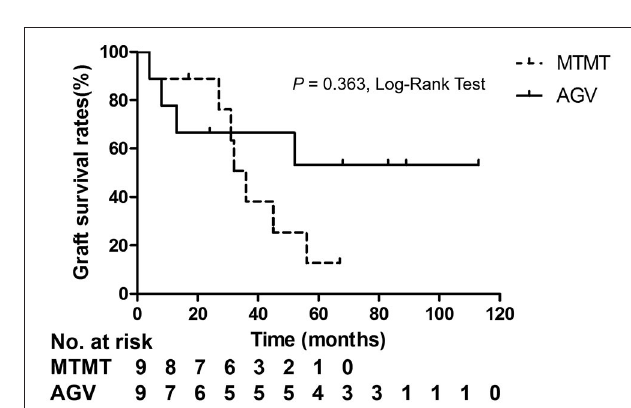
FIGURE 5 | Kaplan–Meier analysis showed no significant differences in graft survival between the two groups.